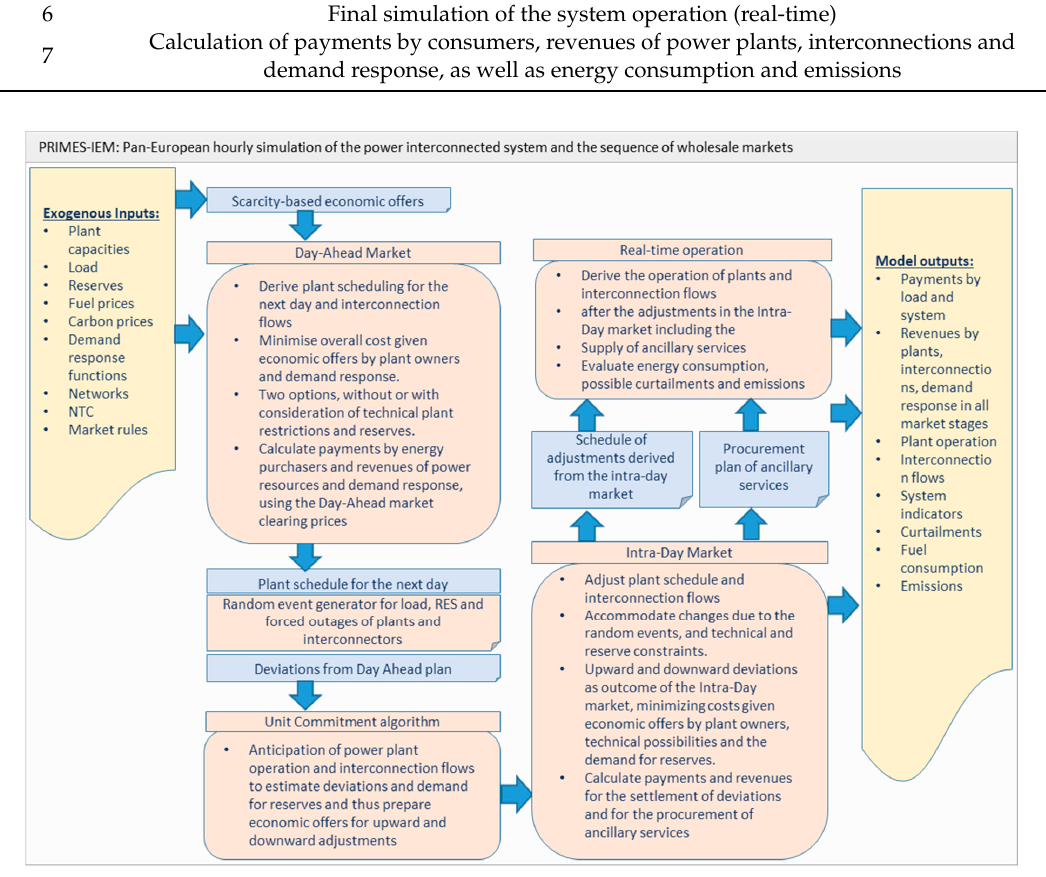
Figure 1. Schematic representation of the PRIMES-IEM modelling approach.